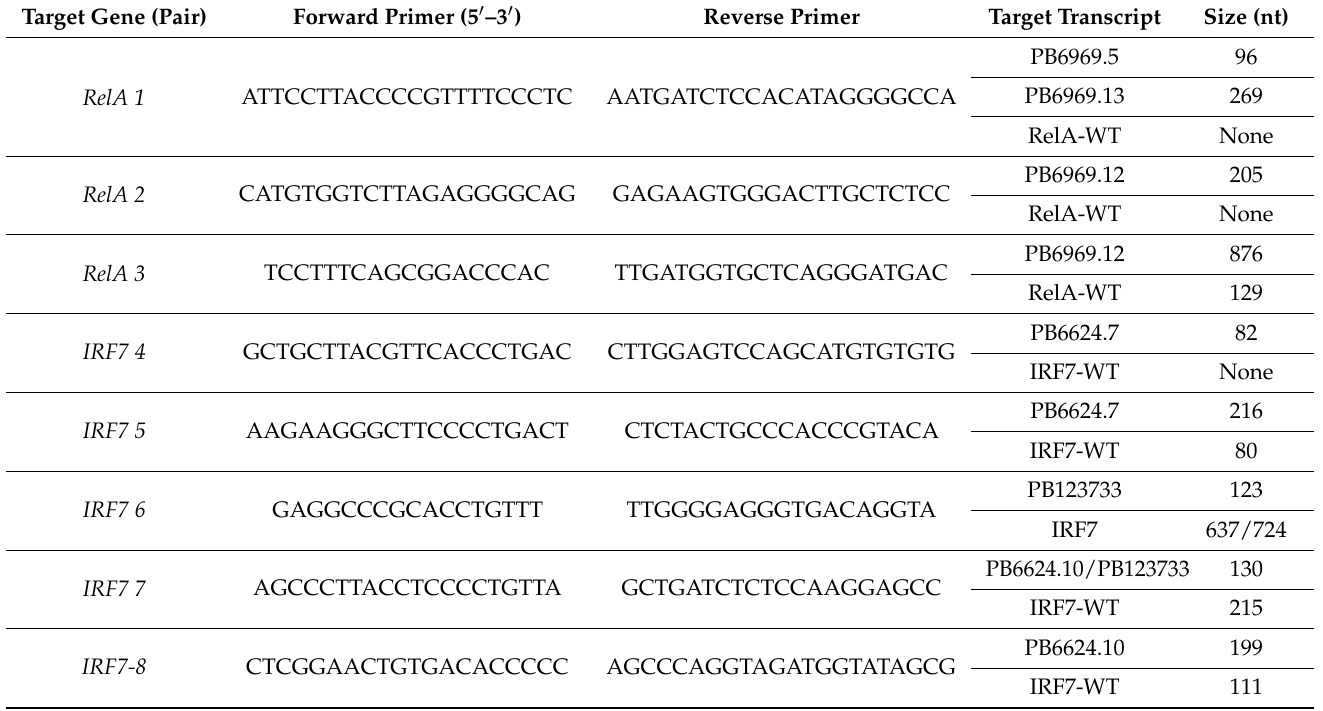
Table 1. Isoform-selective PCR primer